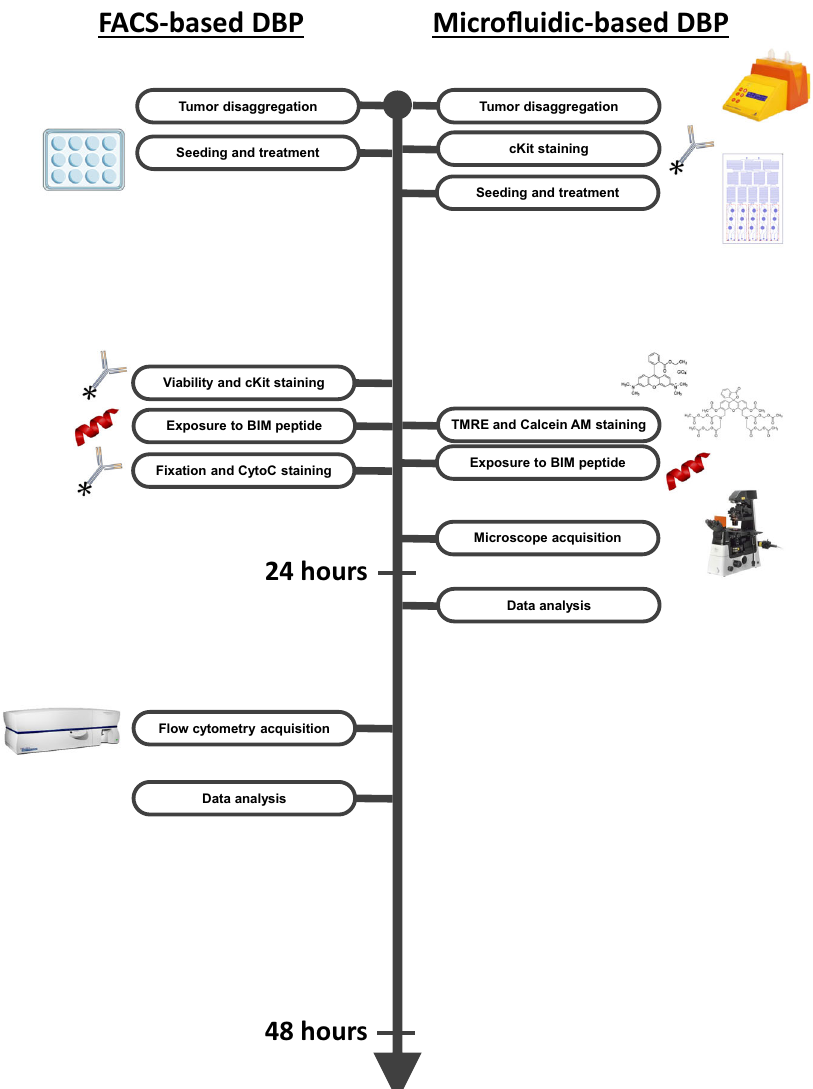
Fig. 1 Micro fl uidic-based DBP protocol is faster than FACS-based DBP. Side-by-side representation of all the steps in the FACS-based DBP (left) and the new micro fl uidic-based DBP